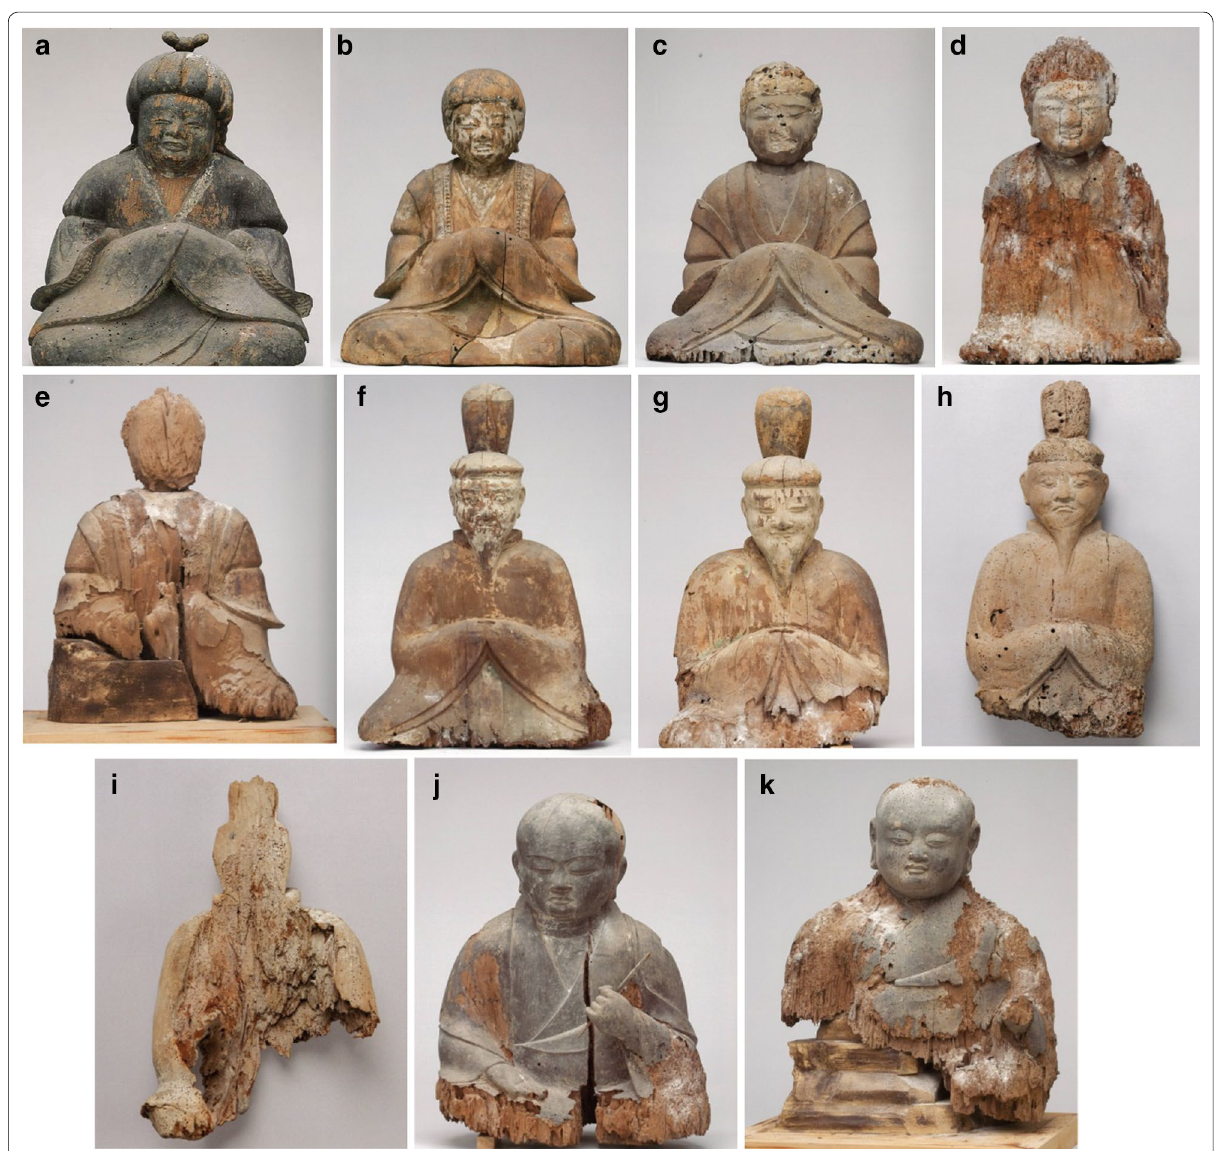
Fig. 1 Photographs of Shinto deity statues in Matsunoo-taisha Shrine ( a – k